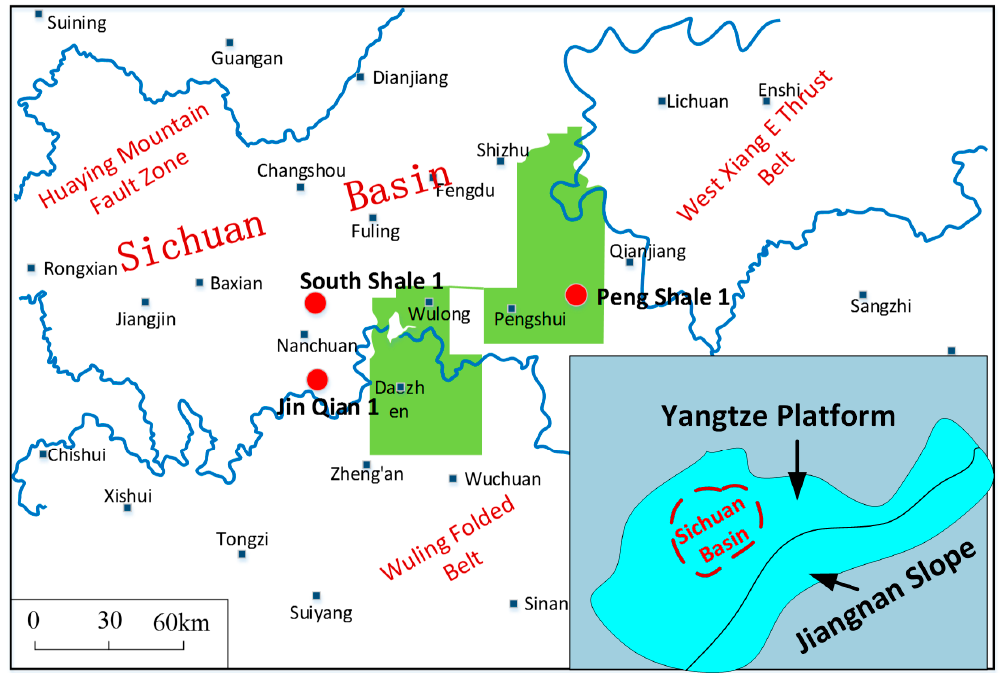
Figure 1. Location and paleogeographic map in South China.